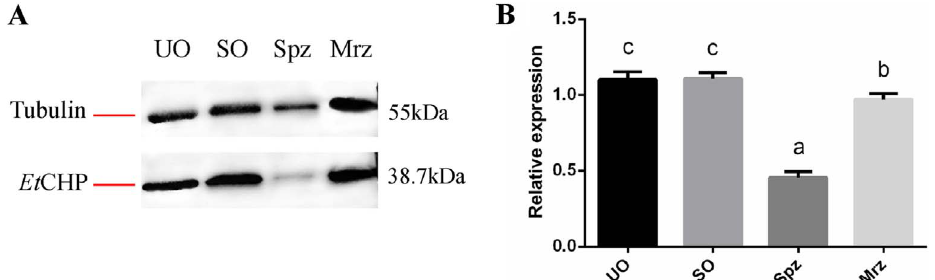
Figure 5. Expression levels of Et CHP18905 in different developmental stages of E. tenella . (A) Western blot of the internal reference tubulin and Et CHP18905 protein. (B) Relative expression levels of the Et CHP18905 protein. Bars with different letters indicate signi fi cantly different expression levels ( p < 0.05) and the error bars indicate standard deviations.